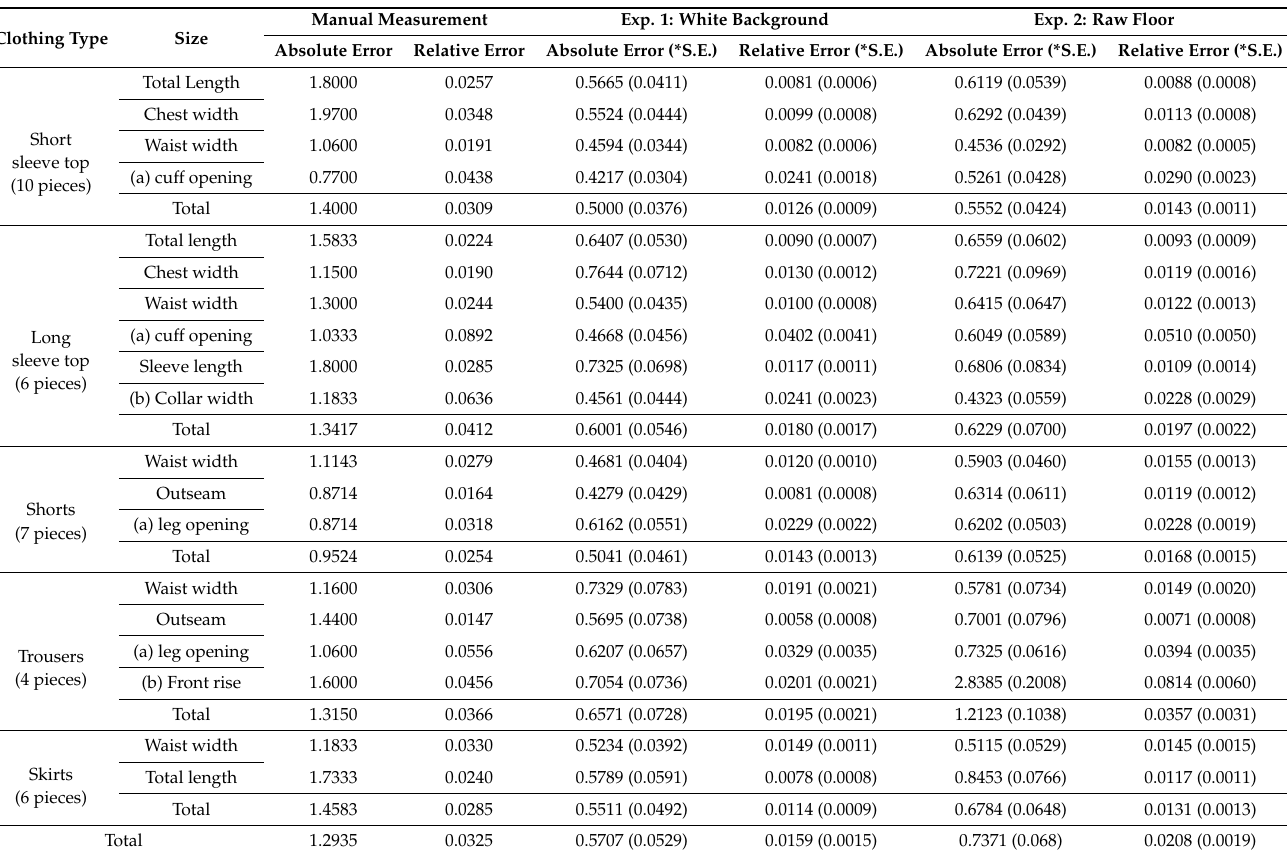
Table A1. Experimental results. Each value on the left side represents the average value and the corresponding value in brackets indicates its standard error